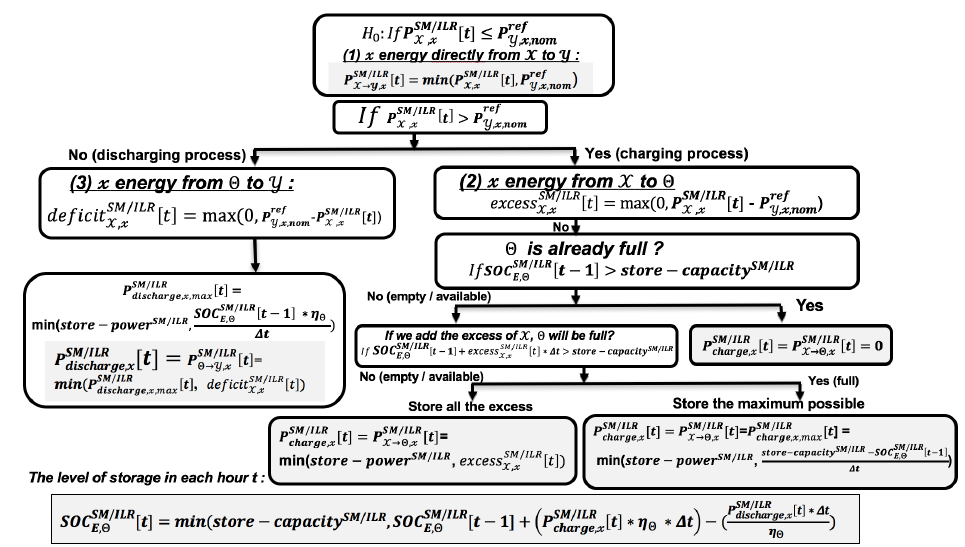
Figure 3. Storage algorithm illustrating the dispatch conditions of CSP thermal (resp., PV Direct Current—DC) energy with constraints on the storage capacity and the maximum power of charging or discharging. X = { SF , SP } ; Y = { PB , INV } ; Θ = { TES , BES } ; x = { therm , DC } ; and y = { elec } . Source: Own elaboration based on